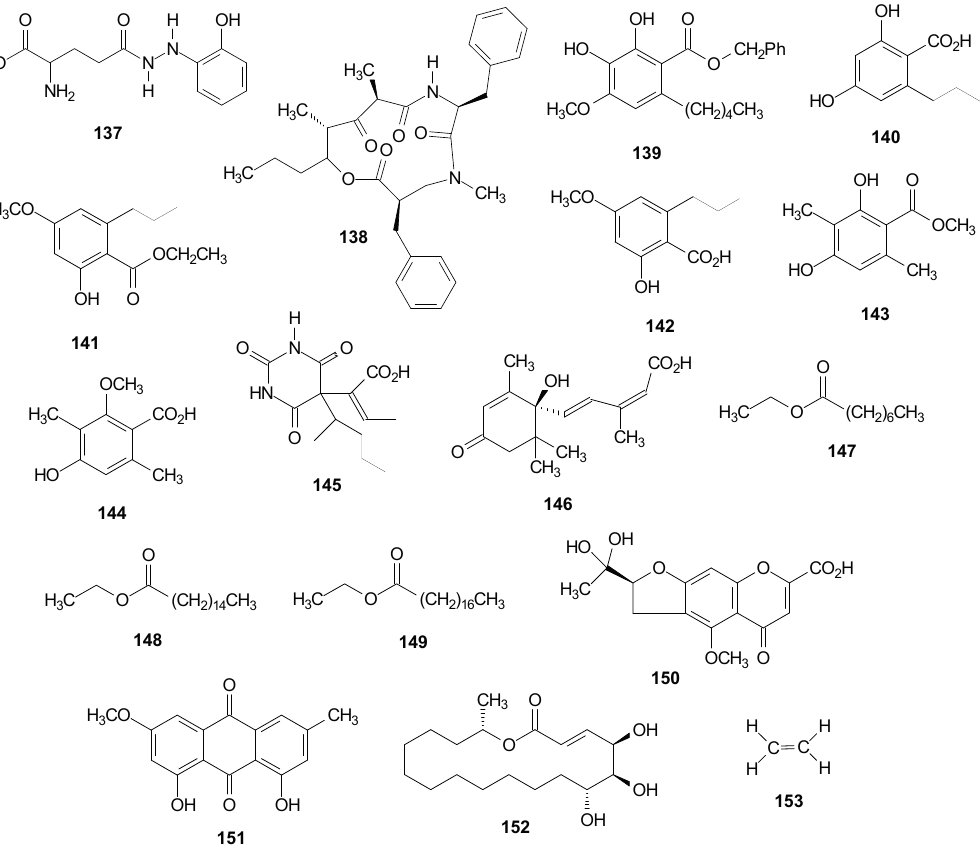
Figure 10. Chemical structures of other compounds from Ramalina species of lichenized